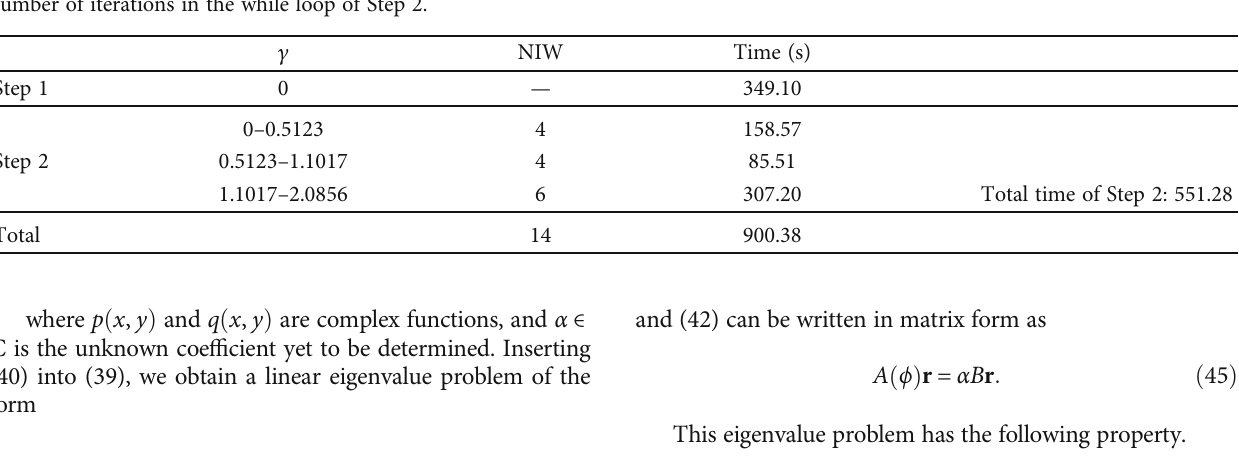
ð x , y Þ = ð 1 : 003 x 2 + 0 : 997 y 2 Þ /2 , ε = 1/ 2